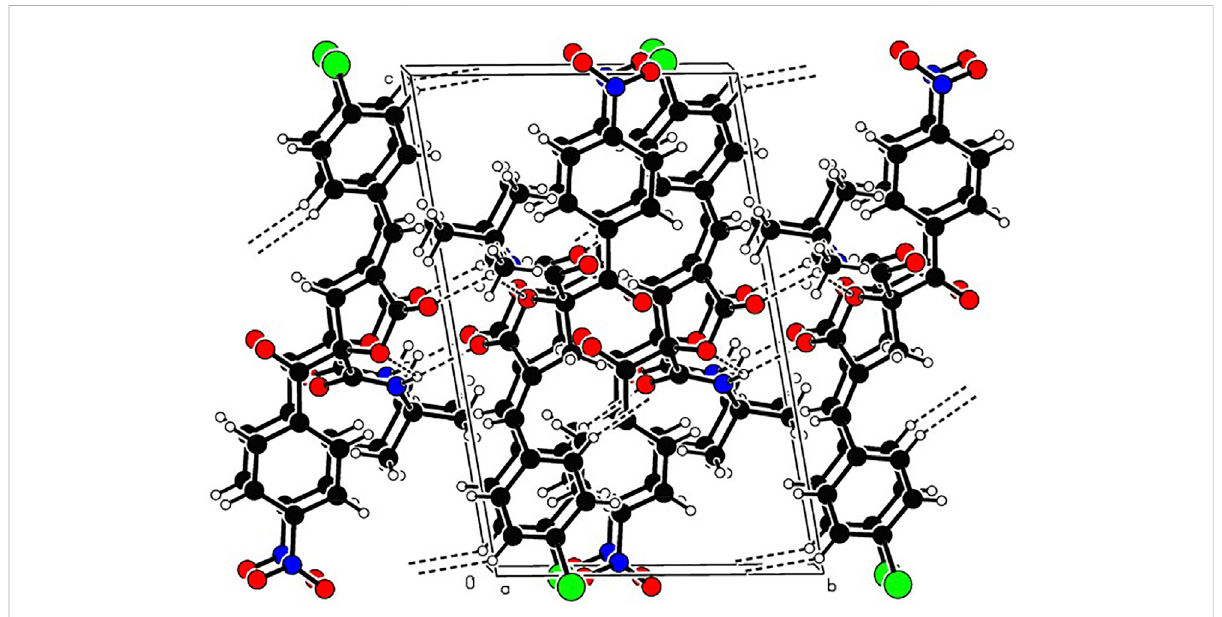
FIGURE 2 Packing of the crystal structure of compound RPDFB. Note: black, carbon; white, hydrogen; red, oxygen; purple, nitrogen; green, chlorine.